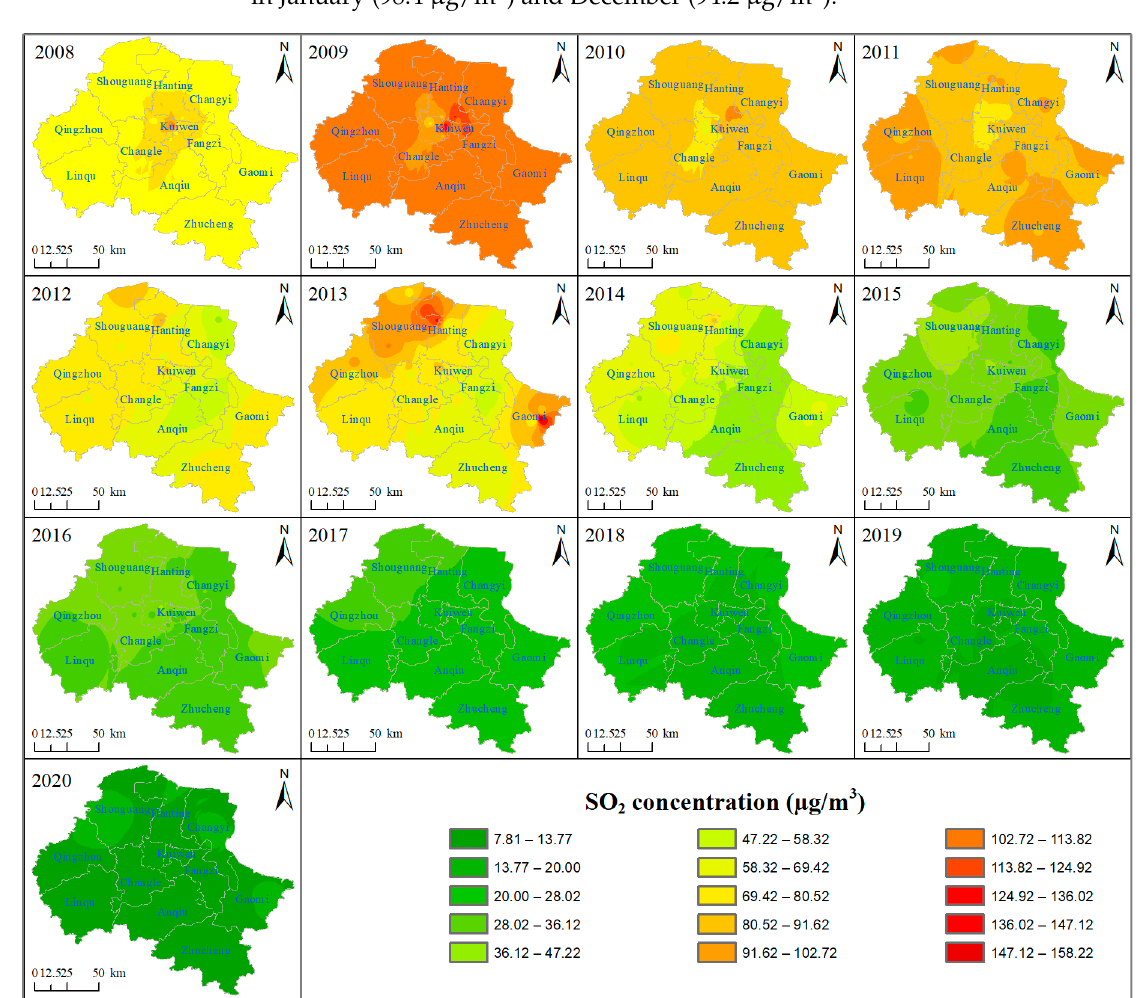
Figure 3. Spatial distribution of SO 2 concentration in Weifang City, from 2008 to 2020.